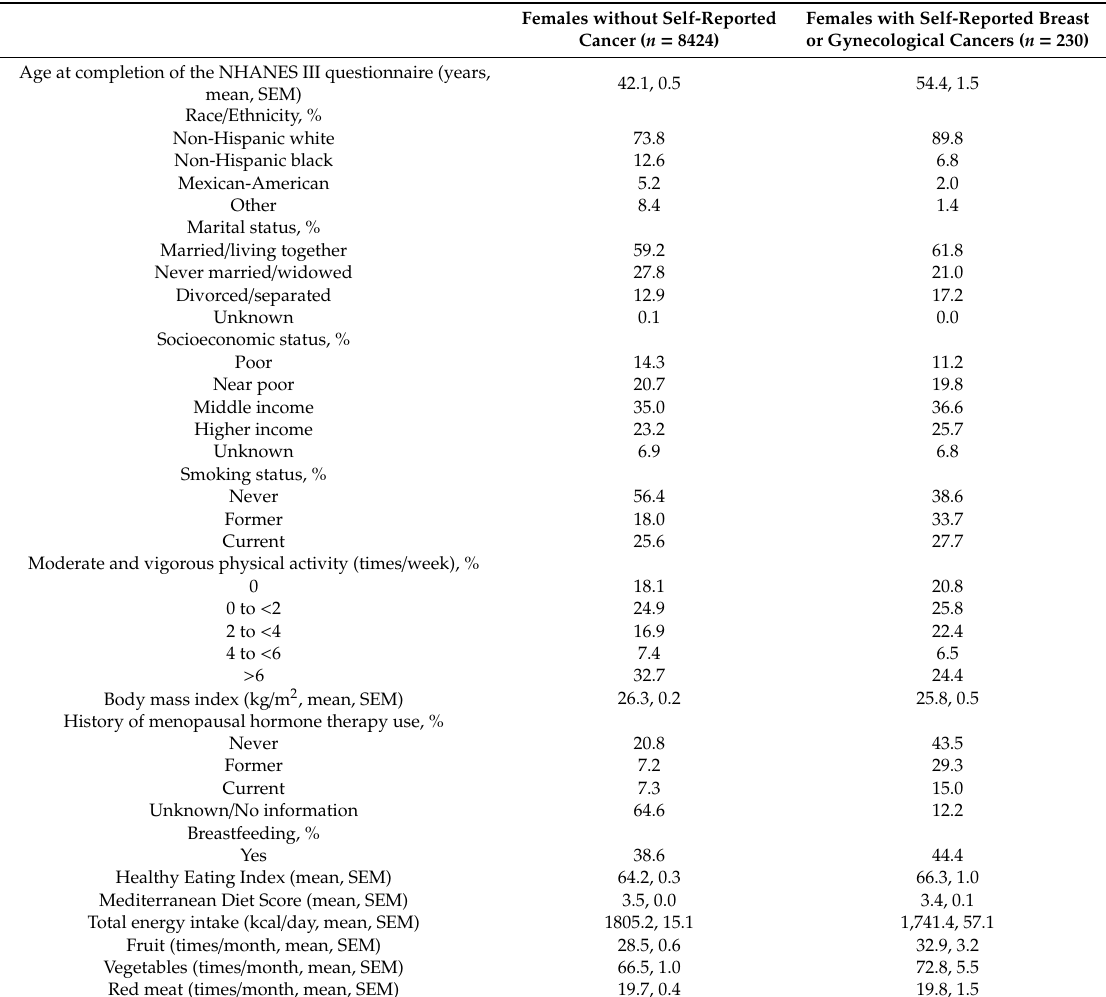
1 SEM: Standard Error of the